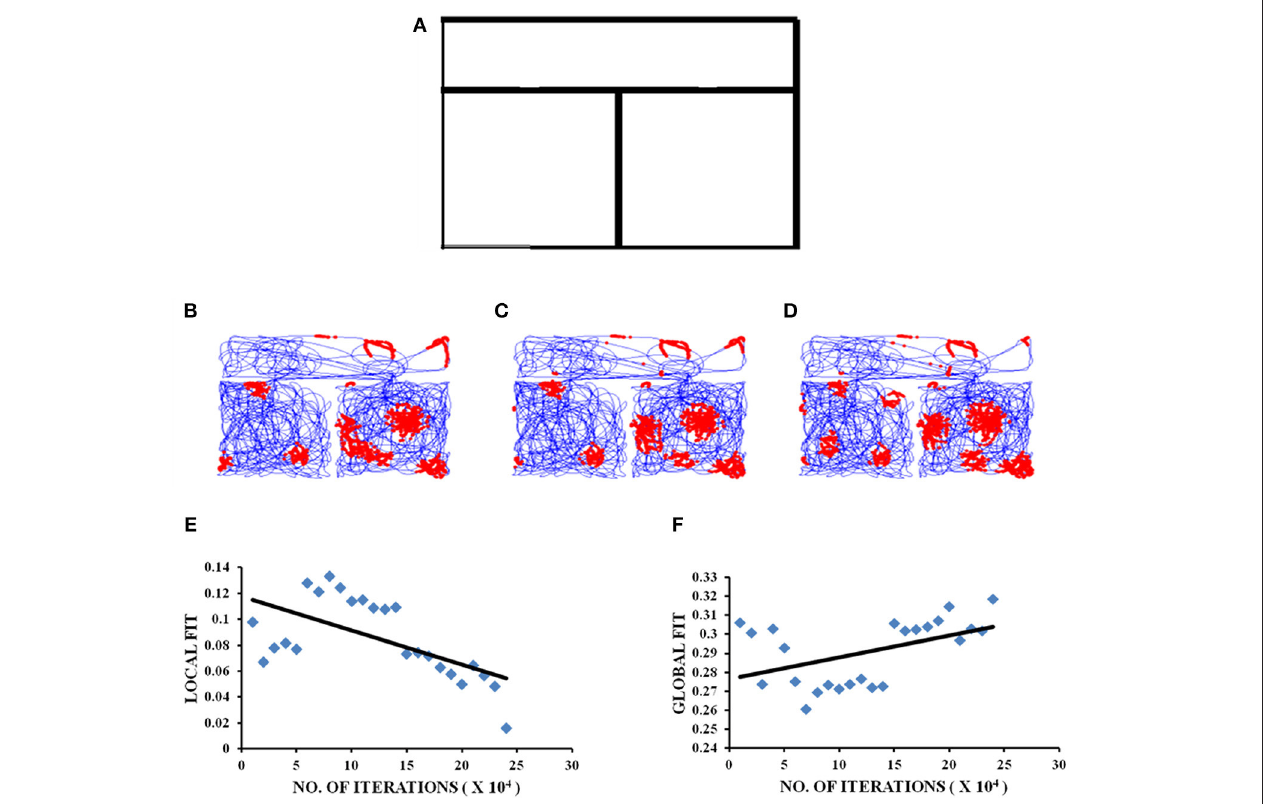
FIGURE 2 | Grid cell firing in square-square connected environment. (A) Boundary of square–square connected environment. (B–D) represent the firing fields of grid cell neuron for square–square connected environment during different training iterations (beginning, middle, and end, respectively) of the model. (E,F) Local and Global HGS values plotted against the no. of training iterations of